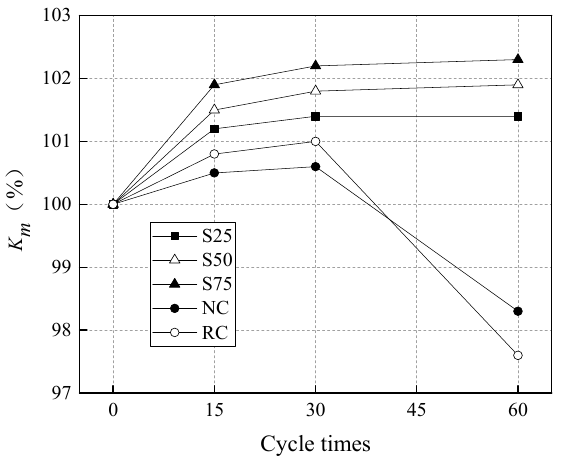
Figure 2. The influence of sulfate attack cycles on the mass loss of specimens.